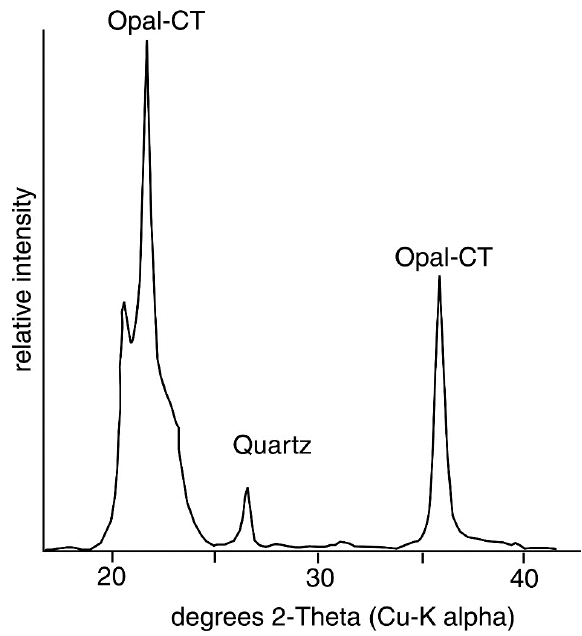
Figure 12. X-ray diffraction pattern for bulk powdered Clover Creek fossil wood.